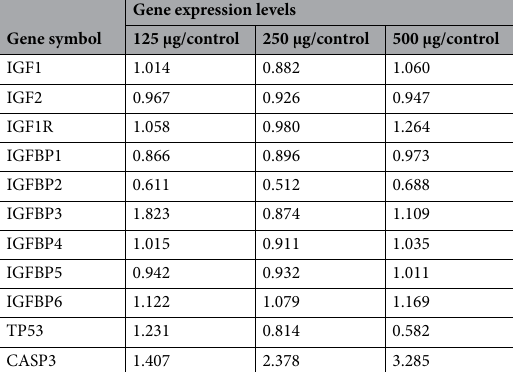
Table 1. Changes in gene expression levels by AOFE treatment in head and neck cancer cells. Apoptosis antibody array analysis was performed using the Full Moon BioSystems Antibody Microarray.